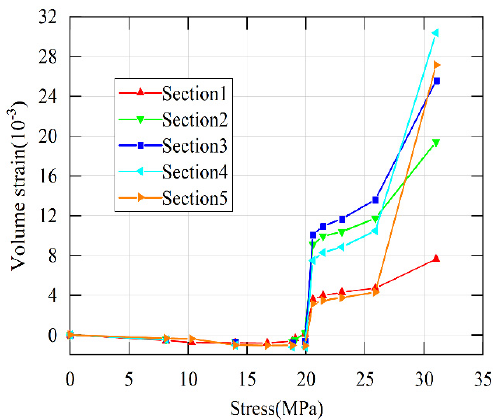
Figure 11. Curve of stress and volume strain.